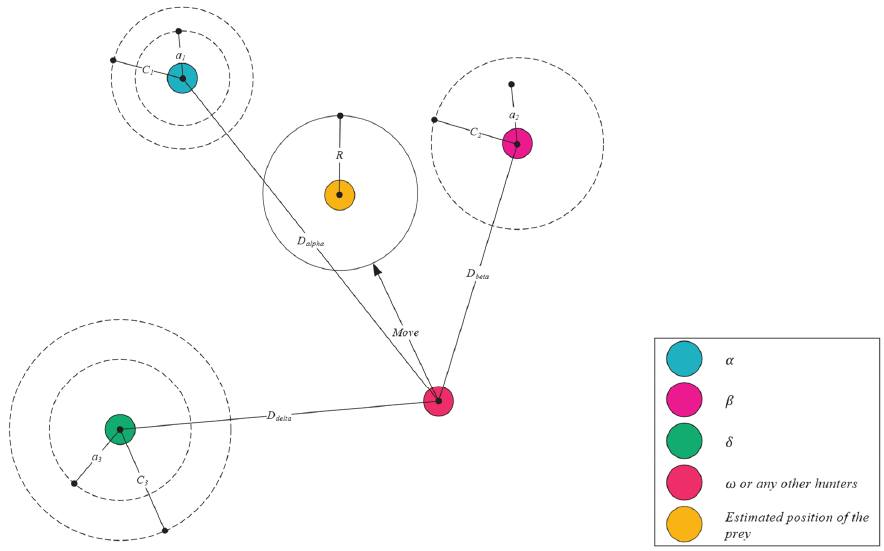
Figure 6. Search steps [27].